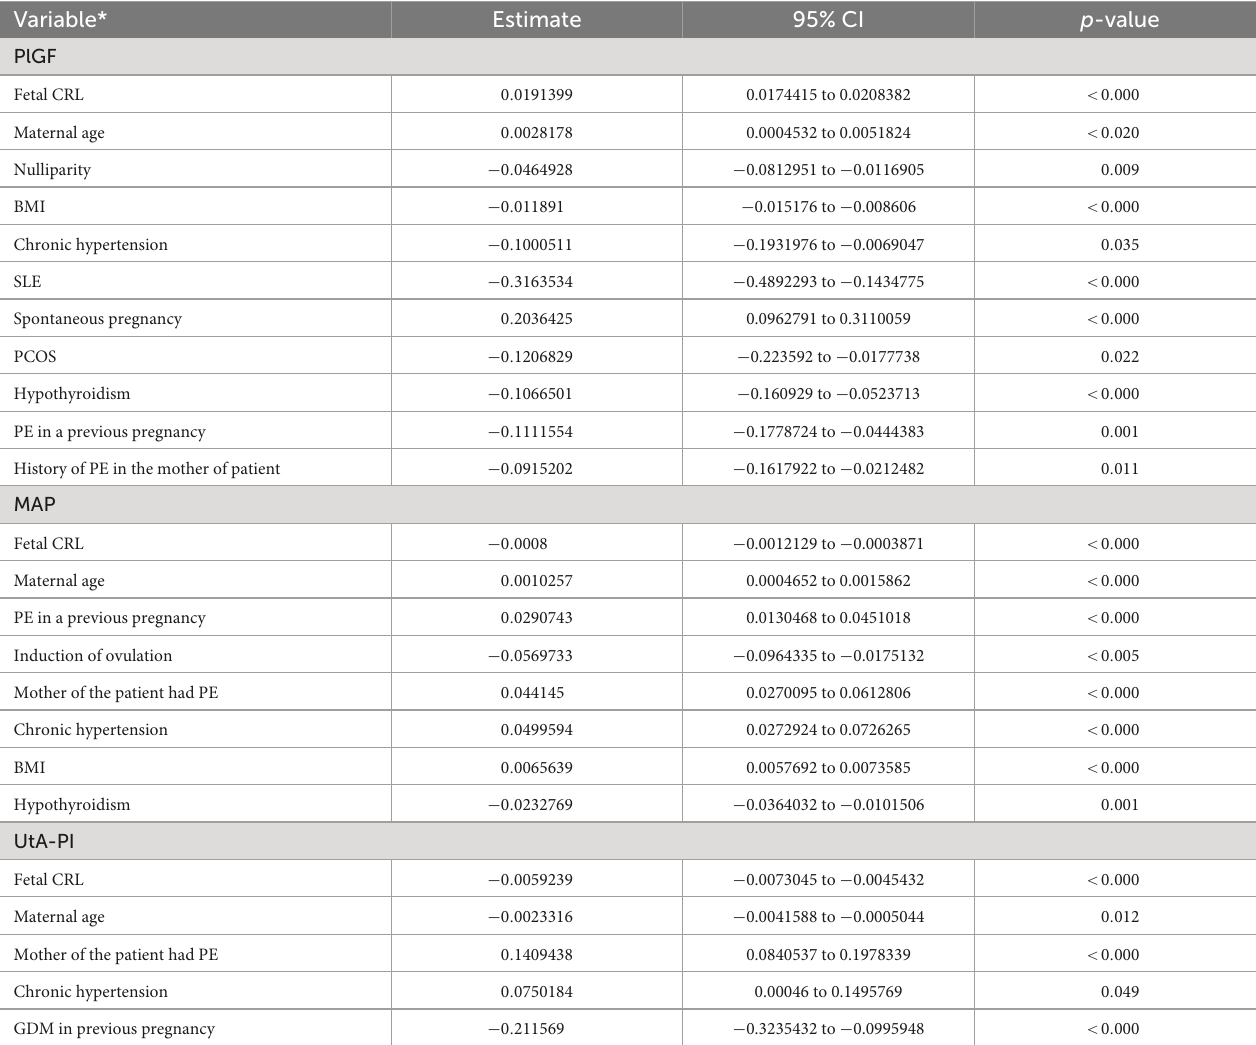
TABLE 2 Multiple regression analysis to identify significant independent contributors to first trimester biomarkers.